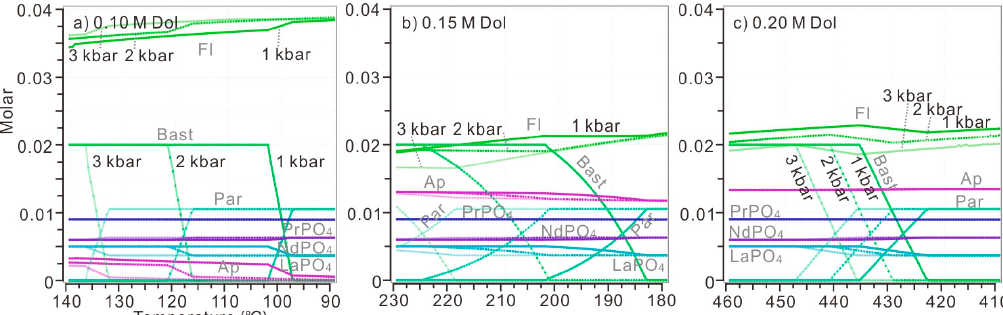
Figure 10. The replacement of parisite by bastnaesite at diverse temperatures and pressures. The initial model solution is the same as fluids in Figure 10. Discrete amounts of dolomite were introduced to the aqueous system: ( a ) 0.10 M; ( b ) 0.15 M; ( c ) 0.20 M. For each plot, the precipitation of REE minerals and gangue minerals have been calculated under the pressure from 1 kbar (solid lines) to 2 kbar (dash lines) then to 3 kbar (transparent lines with spots) and at temperature of 90–140°C for (a), 180–230 °C for (b) and 410–460 °C for (c). These temperature ranges were selected to cover the replacement processes. The temperature decreased 0.5 °C per step.